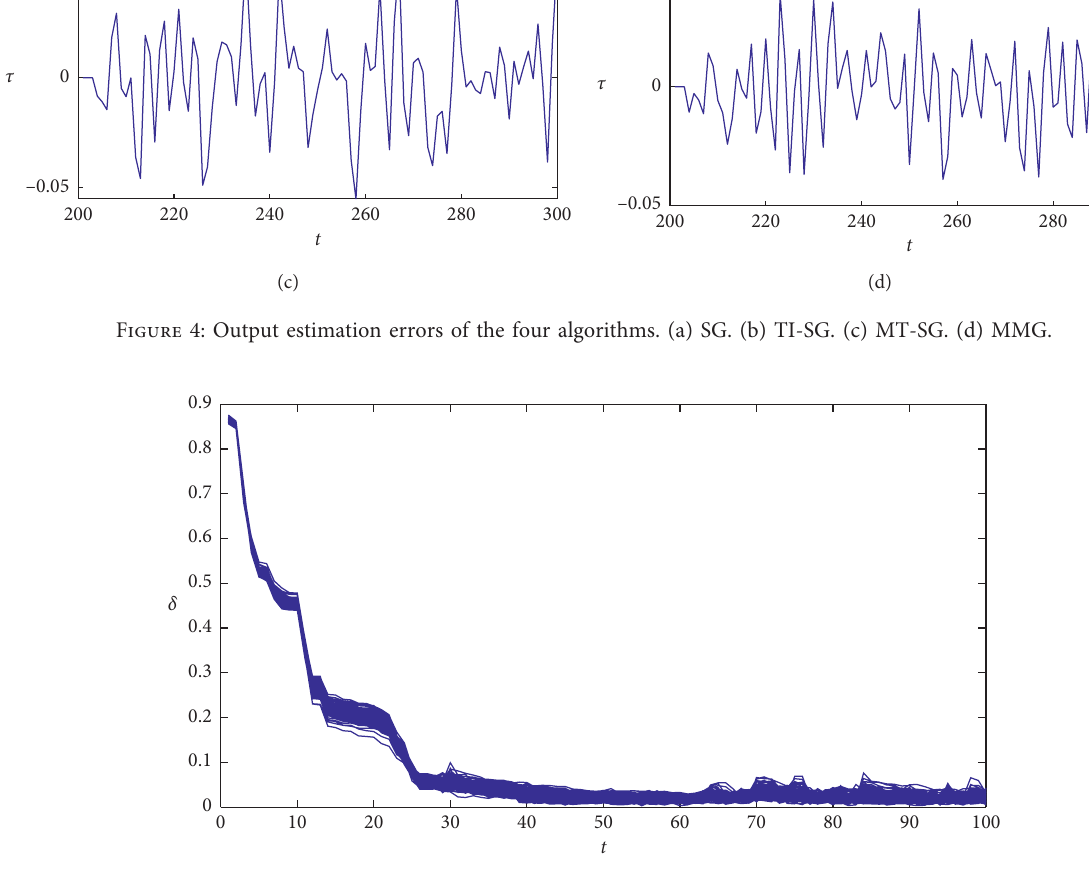
Figure 5: The parameter estimation errors by using the Monte Carlo method.